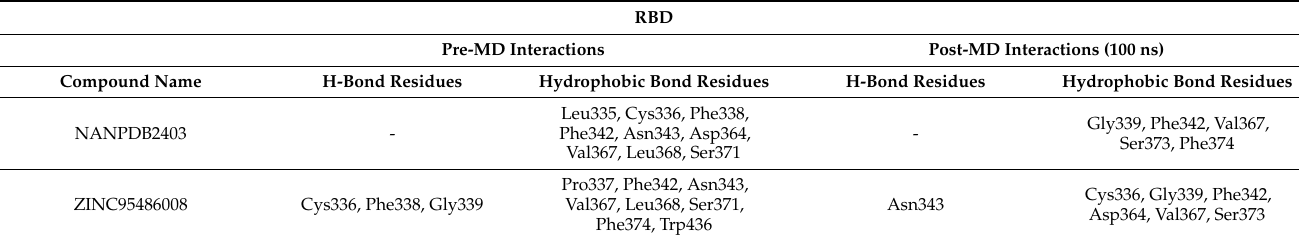
Table 5. Molecular interactions between potential lead compounds and RBD targets before and after MD